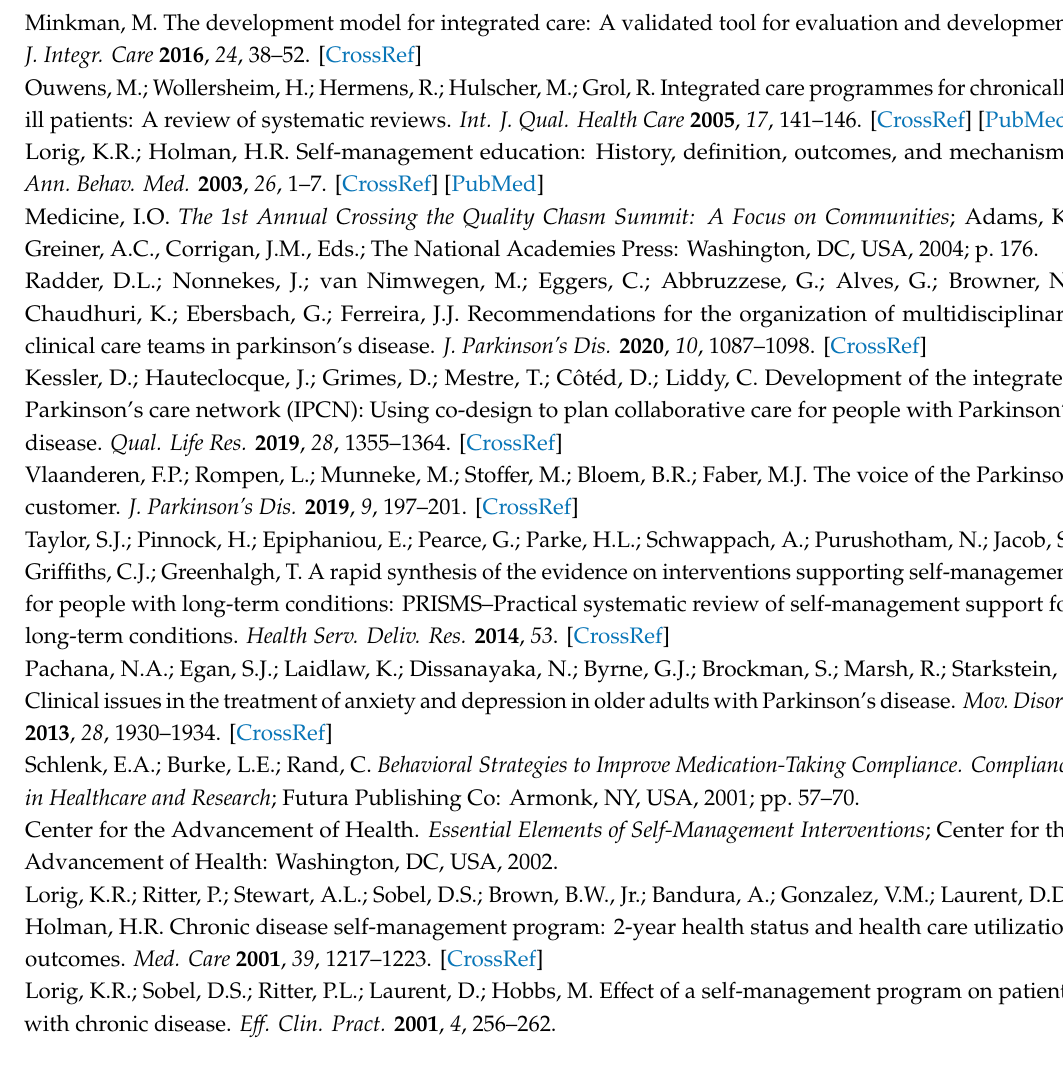
Figure S1: Study flow diagram, Table S1: PRISMA Checklist, Table S2: Other systematic reviews on di ff erent aspects of self-management in Parkinson’s